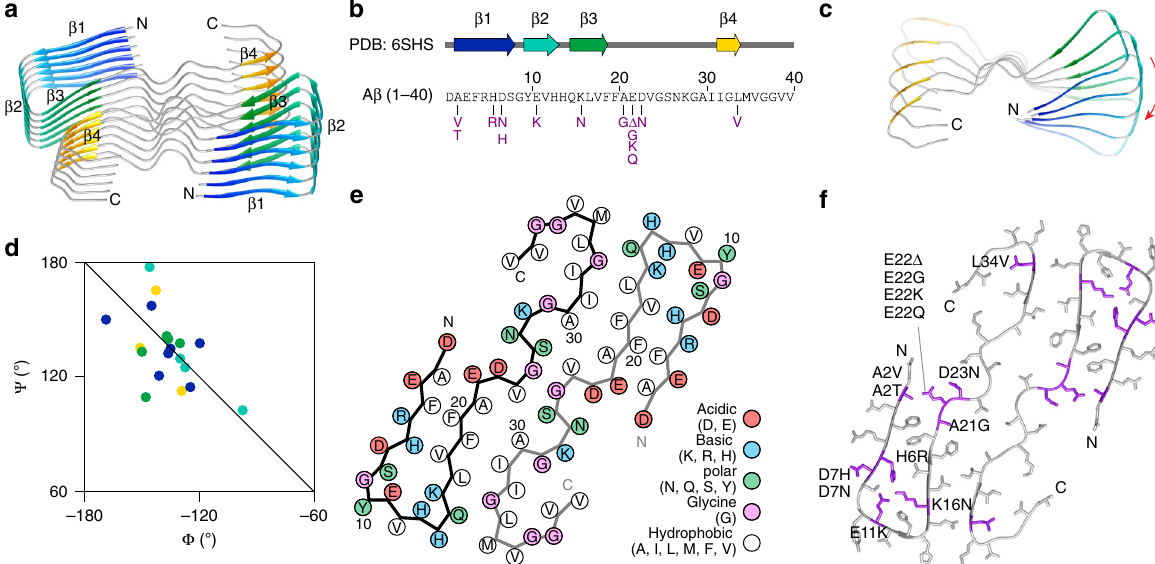
Fig. 3 Peptide fold of fi bril morphology I. a Ribbon diagram of six layers of the fi bril. b Location of β -strands β 1 – β 4 within the A β (1 − 40) sequence. Mutations are shown in magenta. c Top view of a peptide stack showing the right-hand β -sheet twist. Only every sixth molecule shown. d Section of the Ramachandran plot showing the Φ / Ψ -pairs of the residues within β -strands β 1 − β 4. The β -strand color coding is kept consistent in panels ( a – d ). e Packing scheme of one molecular layer of the fi bril. f Cross-sectional view of the fi bril with the known mutational variants highlighted in magenta